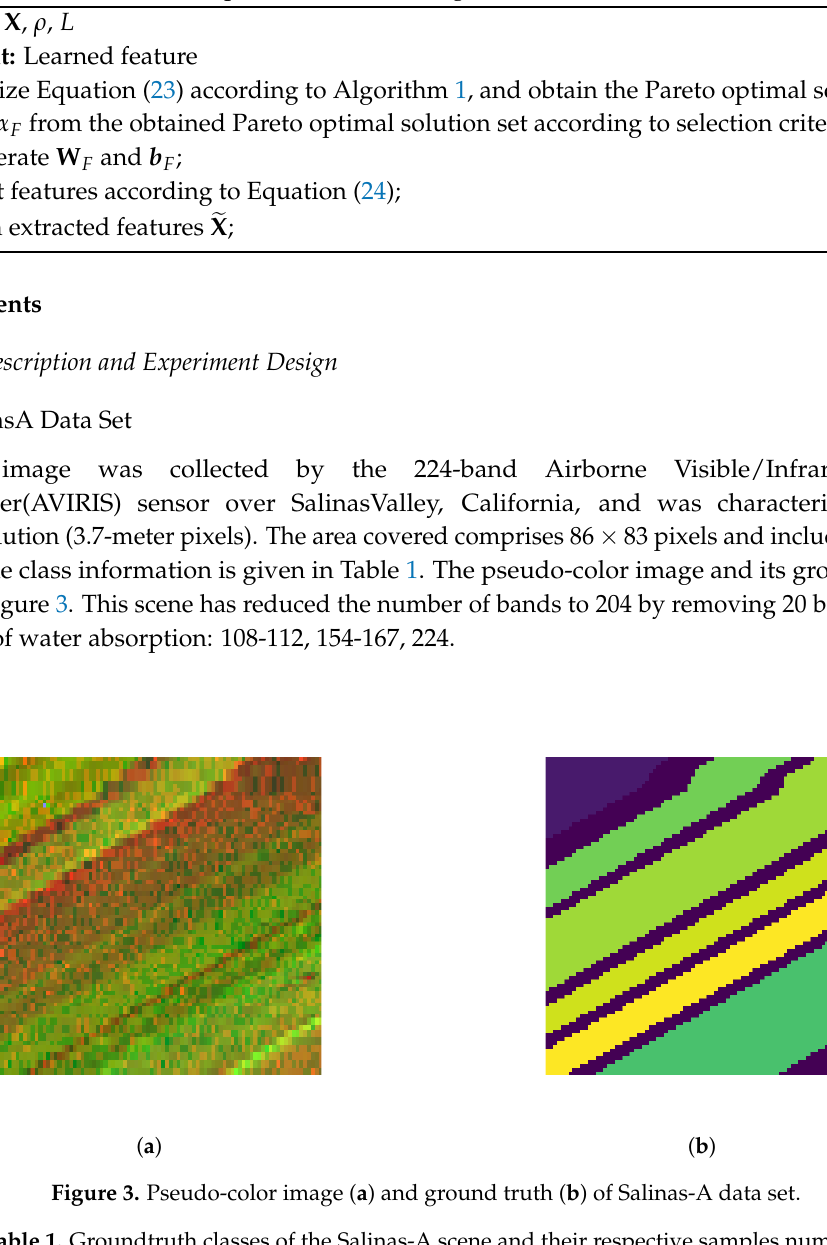
Algorithm 2: EMO-ELM for sparse feature learning